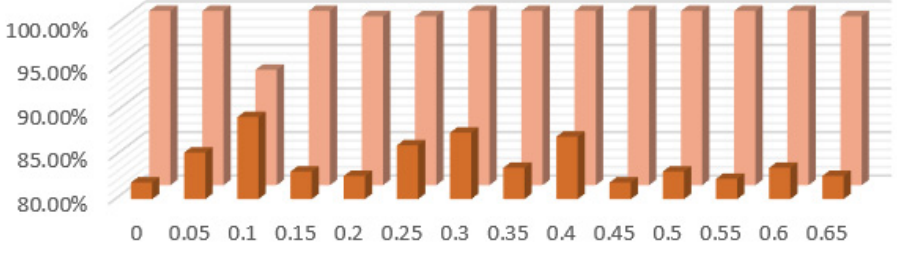
Figure 8. Changes in precision and recall.